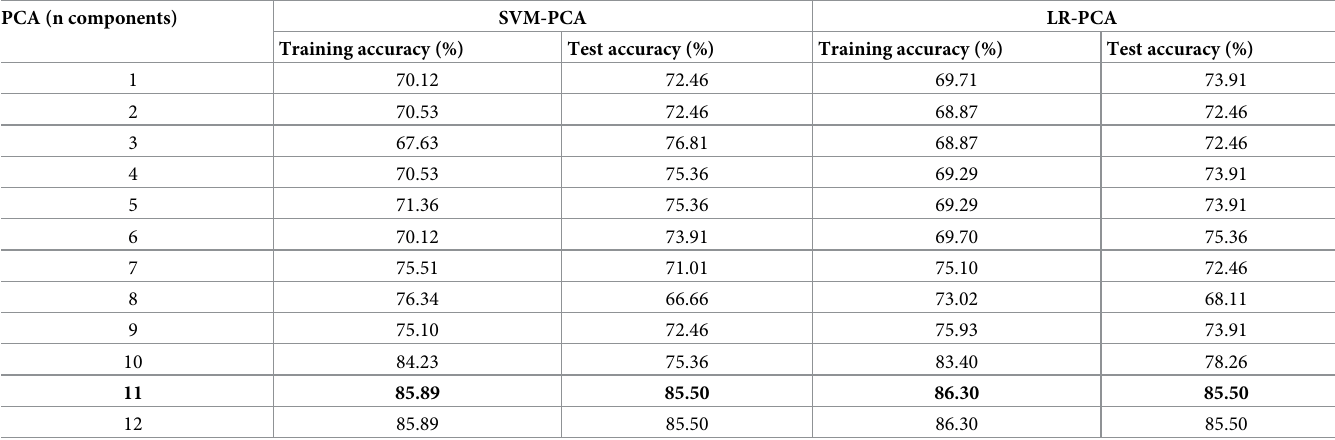
Table 7. Result of SVM-PCA and LR-PCA.